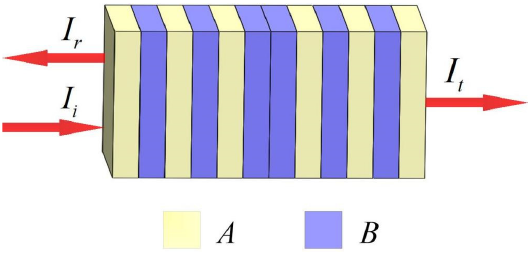
Figure 1. Schematic diagram of one-dimensional symmetrical truncated photonic crystal structure ( AB ) N ( BA ) N for N = 3. ( AB ) N ( BA ) N for N =